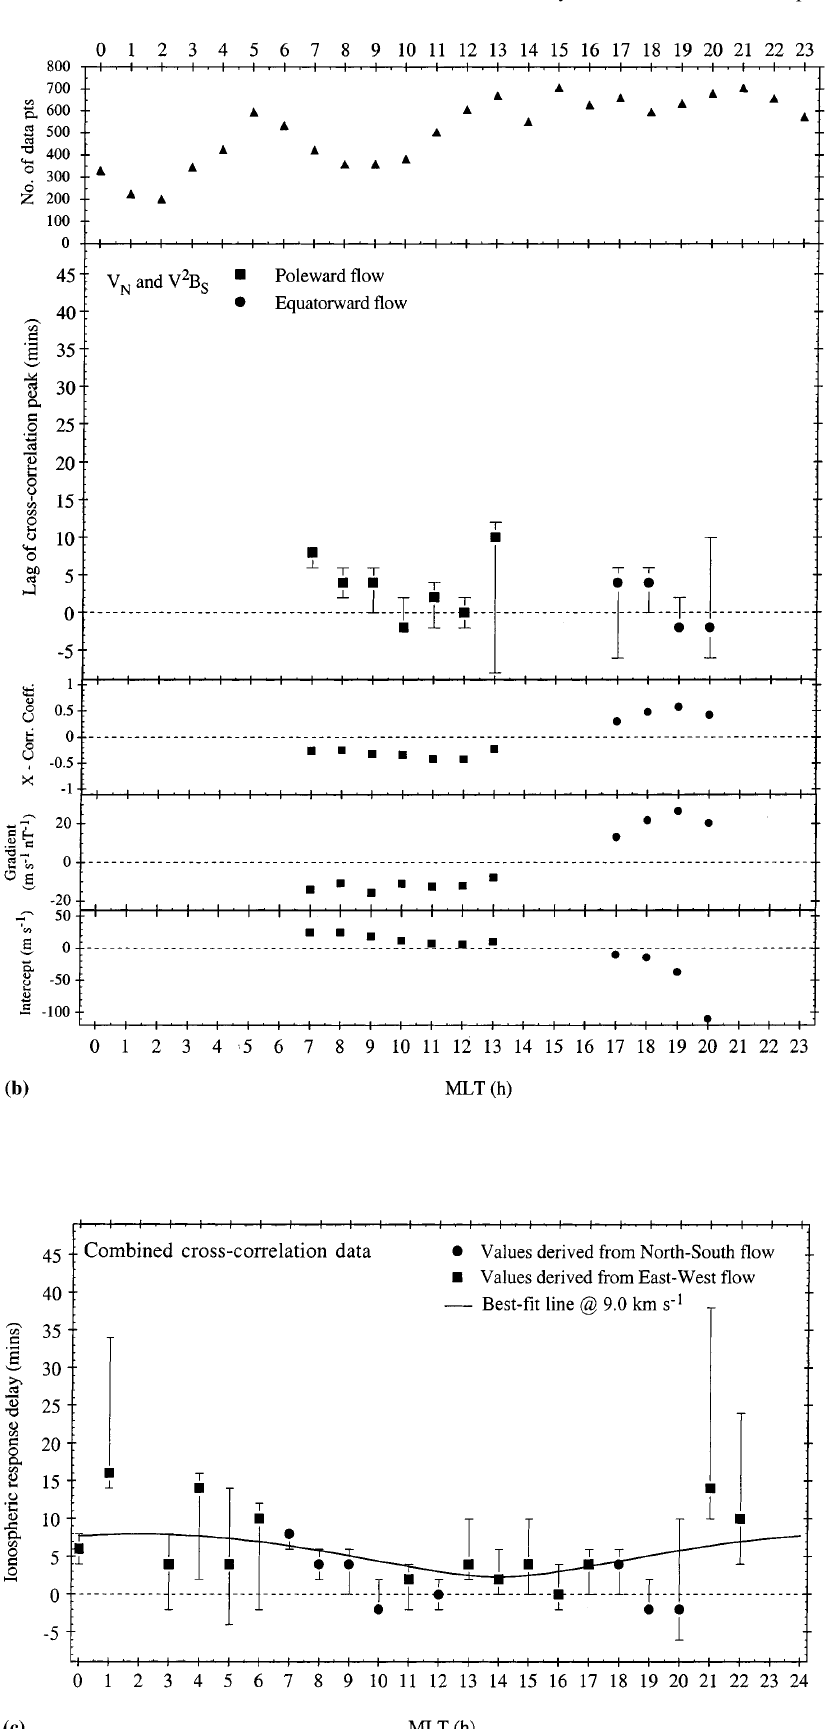
Fig. 5. c Response delay values for the com- bined north-south and east-west cross-correla- tion data set, where the squares indicate values derived from the east-west flow, and circles values derived from the north-south flow. Where both components provide a value, the lower of the two has been used, and where both give the same value, the data point with the smaller error bars is shown. The solid line shows a simple theoretical curve which has been least- squares fit to these values, in which information propagates radially from the open-closed field line boundary at 77 (cid:176) magnetic latitude. The best- fit line corresponds to a propagation epicentre located at 1400 MLT, and a phase speed of 9.0 km s )